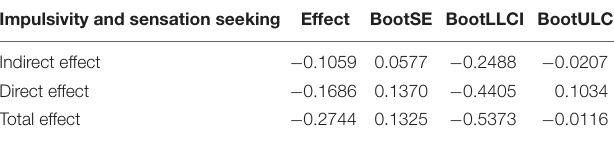
TABLE 5 | Mediating effects of sensation seeking by bootstrapping analysis.